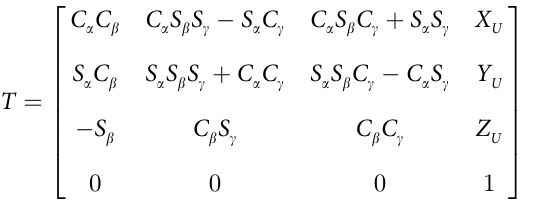
= 0 (first actua- c ffiffiffi p ¼ (cid:0) 3 (third x c c